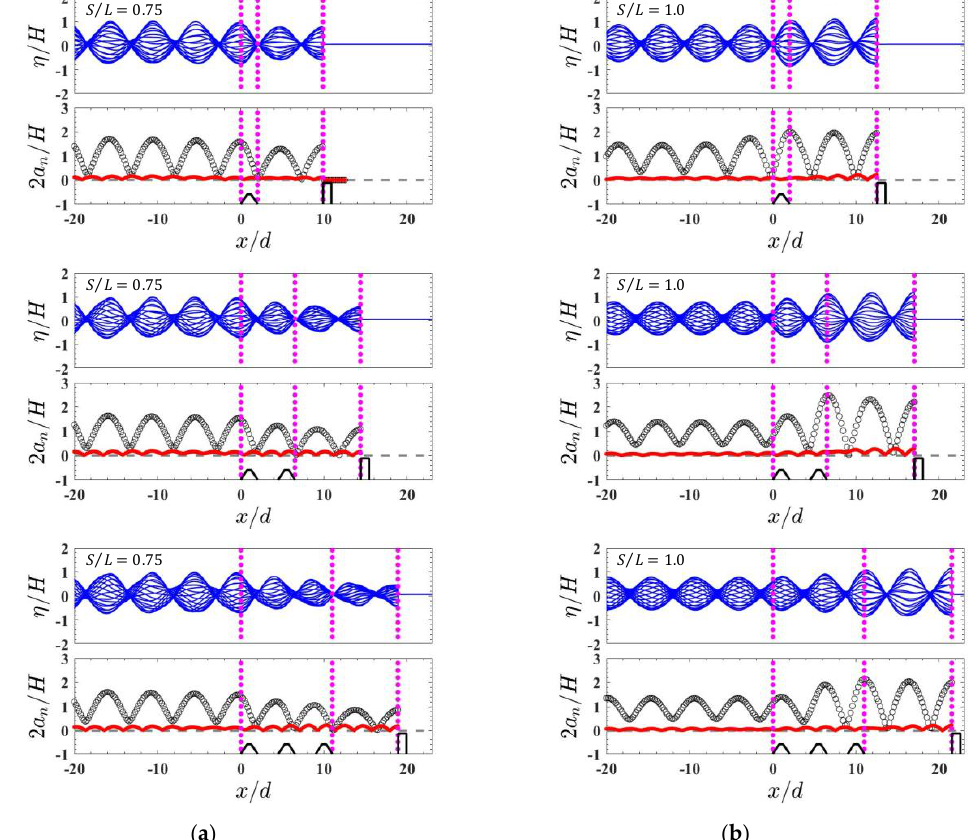
Figure 6. Wave surface elevations and the spatial evolution of the harmonic amplitude (symbols: o: first harmonic; •: second harmonic) at different resonator length s. ( a ) 𝑆 𝐿⁄ = 0.75 . ( b ) 𝑆 𝐿⁄ = 1.0